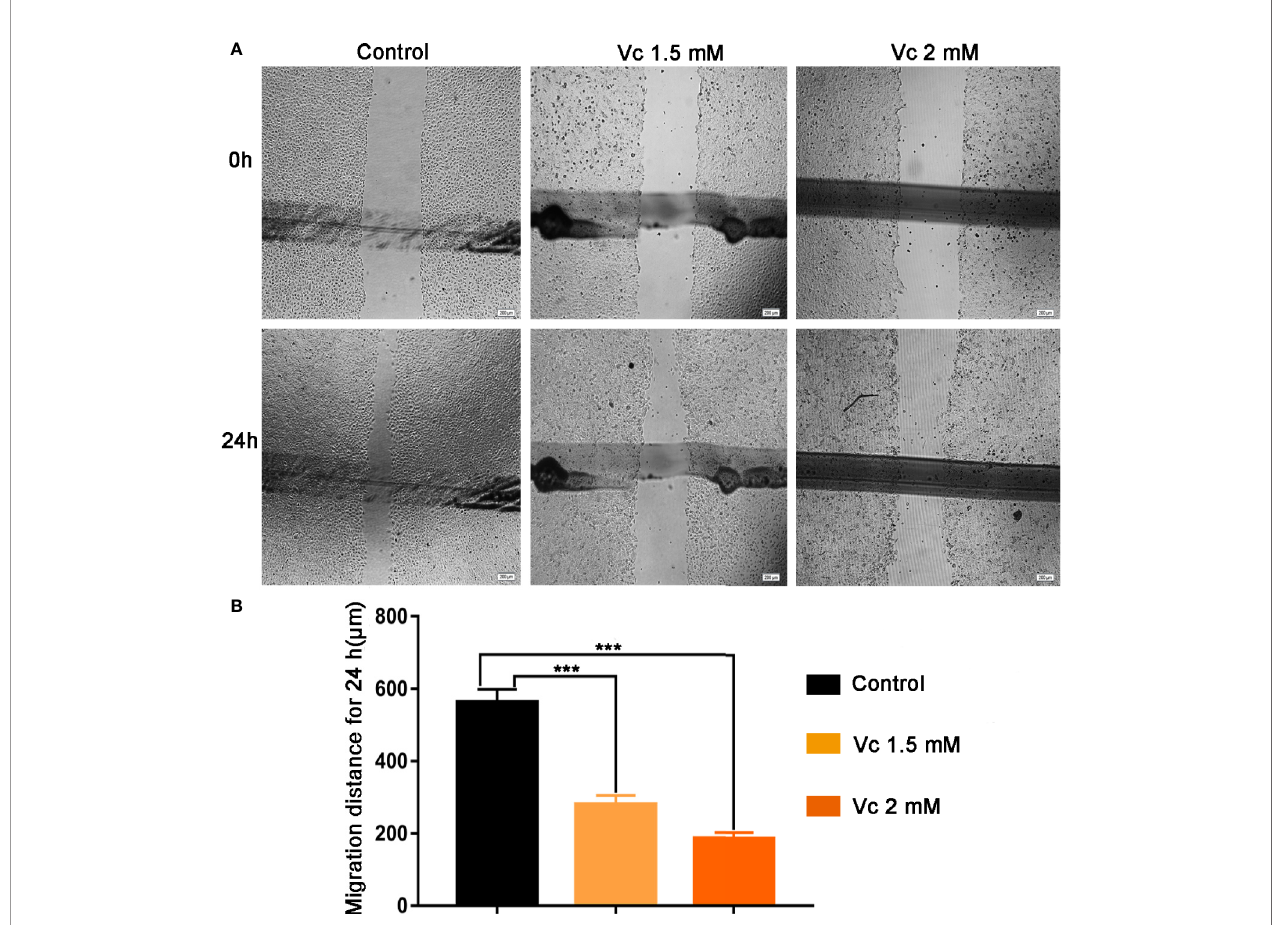
FIGURE 9 | Effect of Vitamin C on ID8 cell migration. Migration of ID8 cells was evaluated using the in vitro wound-healing scratch assay. (A) Representative photomicrographs of ID8 cells. (B) For quantitative analysis, migration distance of cells was determined. Data are mean ± SEM; n=4. ***p <